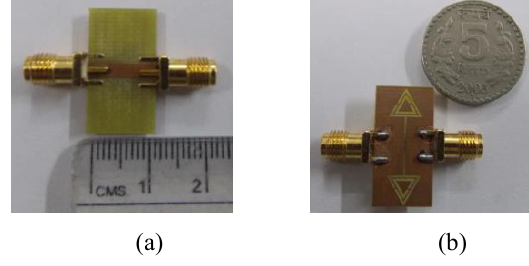
Fig. 7: Fabricated layout of proposed dual-band microstrip bandstop filter with triangular CSRR-DGS: (a) top view (b) bottom